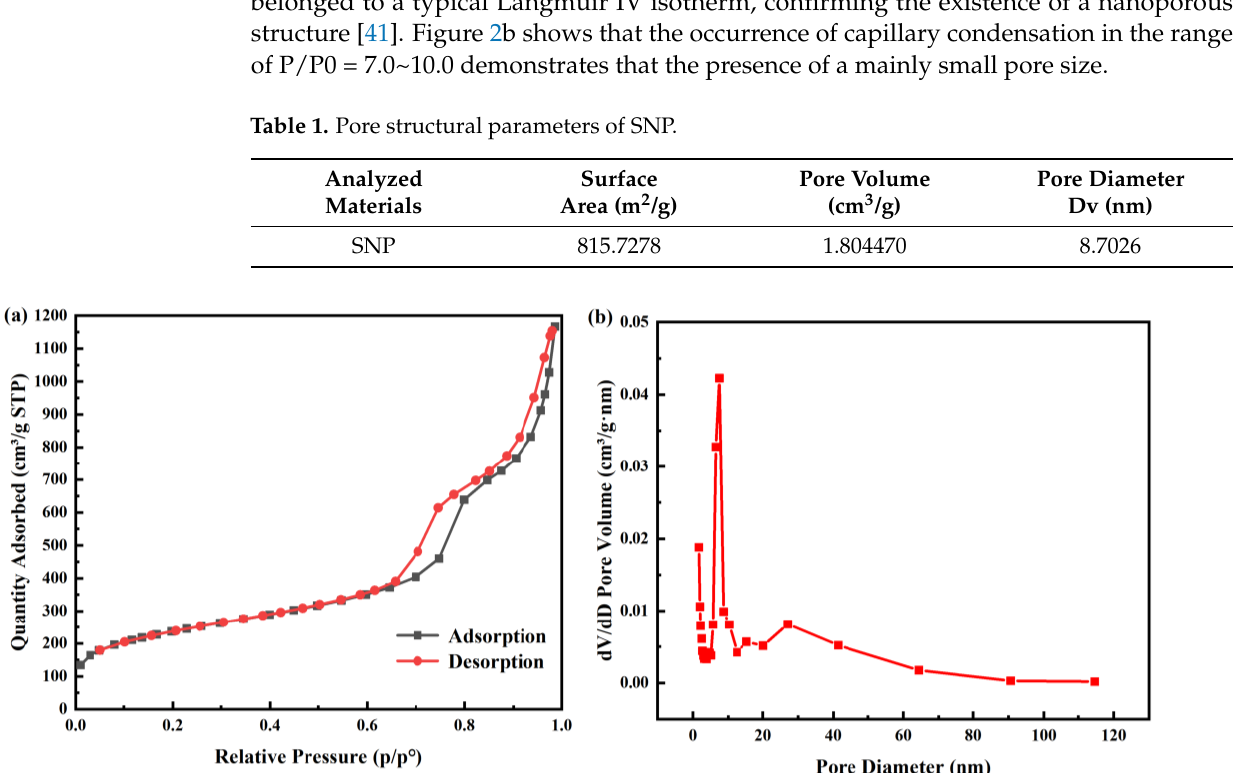
Figure 3. Scanning electron microscope (SEM) images of SNP ( a ) and CEO-SNP ( b ), and transmis- sion electron microscope (TEM) images ( c , d ) of SNP. Table 1. Pore structural parameters of SNP. Analyzed Materials